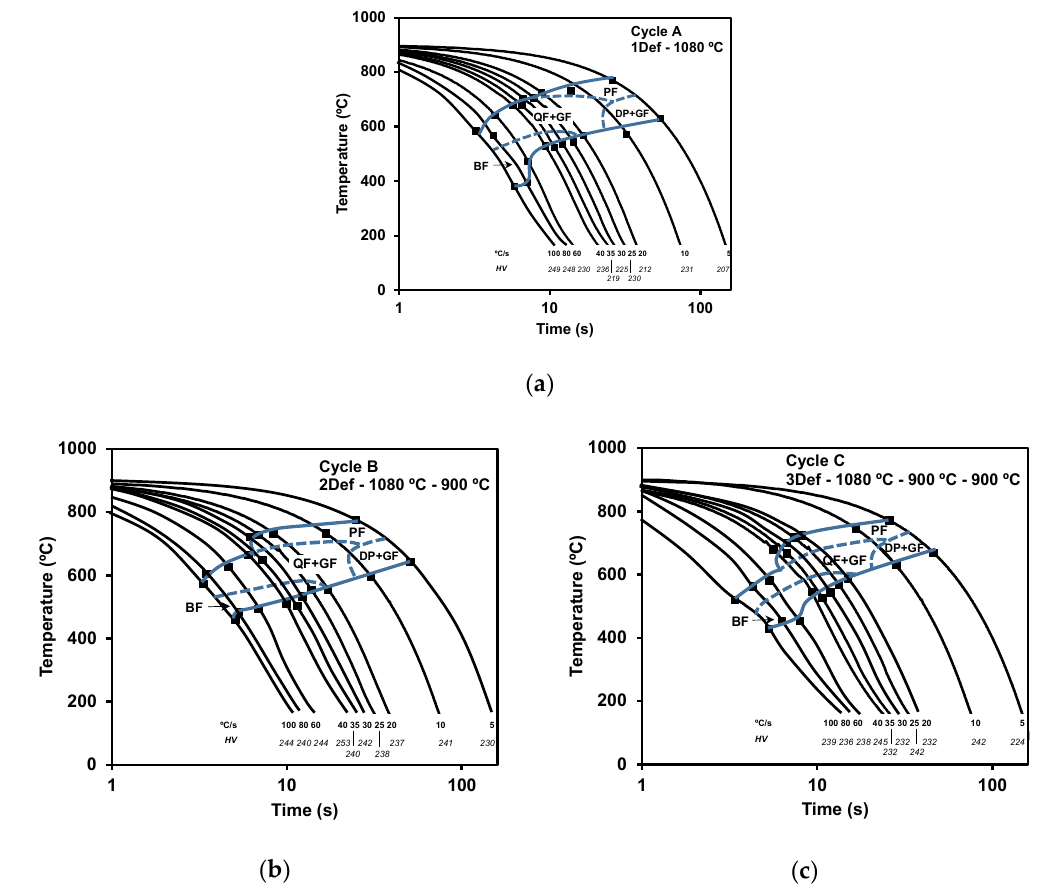
Figure 3. CCT diagrams corresponding to each thermomechanical cycle: ( a ) Cycle A, ( b ) Cycle B, and ( c ) Cycle C. Black lines represent the cooling profile followed at each cooling rate and blue lines determine the stability region of the different phases.